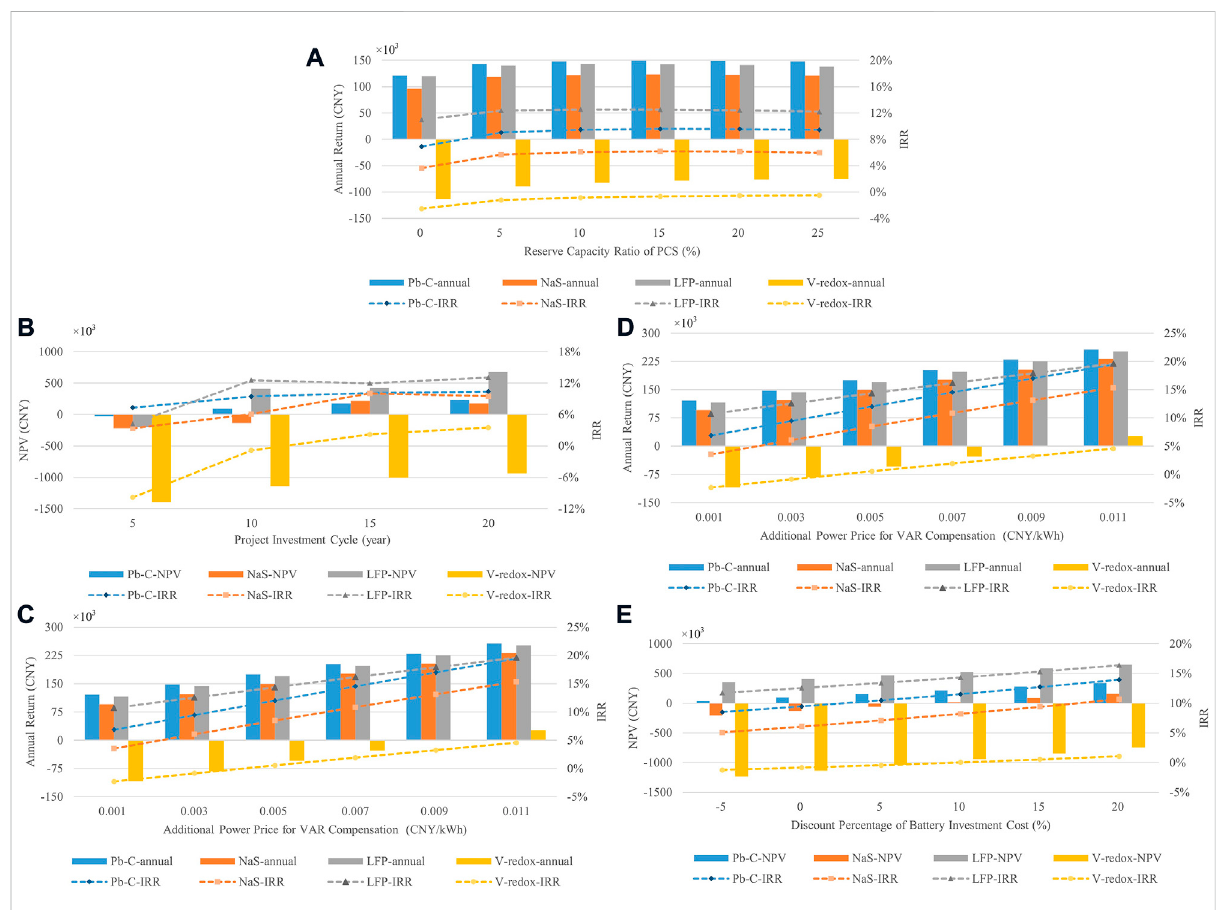
FIGURE 1 Annual return, NPV, and IRR with fi ve sensitive factors: (A) reserve capacity ratio of PCS, (B) project investment cycle, (C) additional power price for VAR compensation, (D) peak-valley price ratio, and (E) discount percentage of battery investment